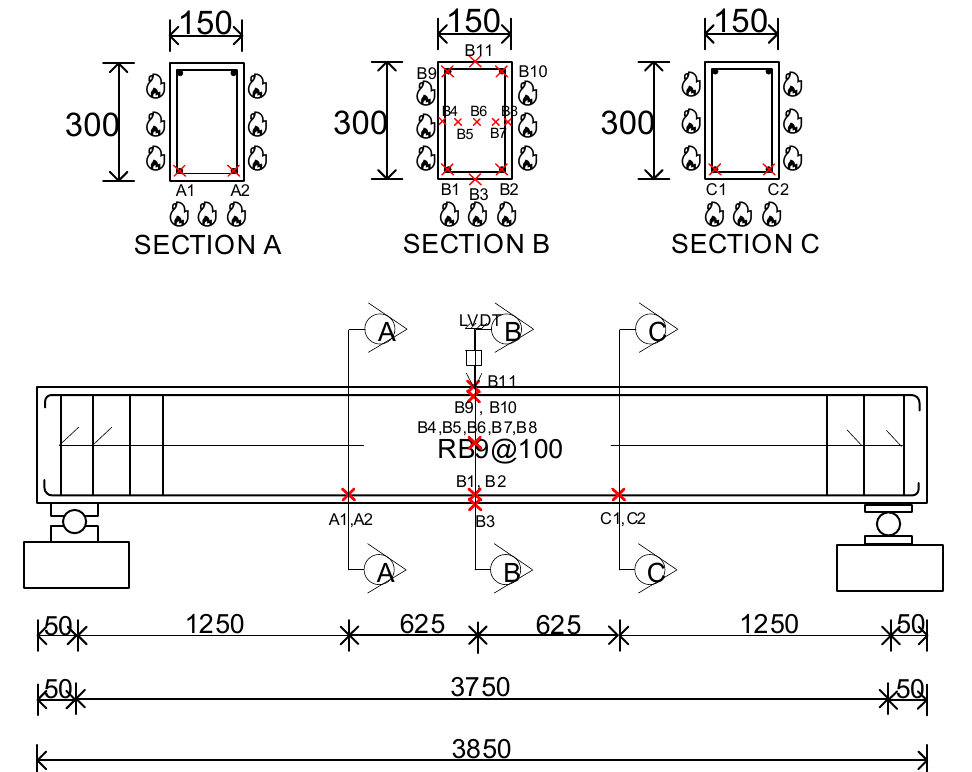
Figure 3. LVDT and thermocouple installation location of the sample beam.